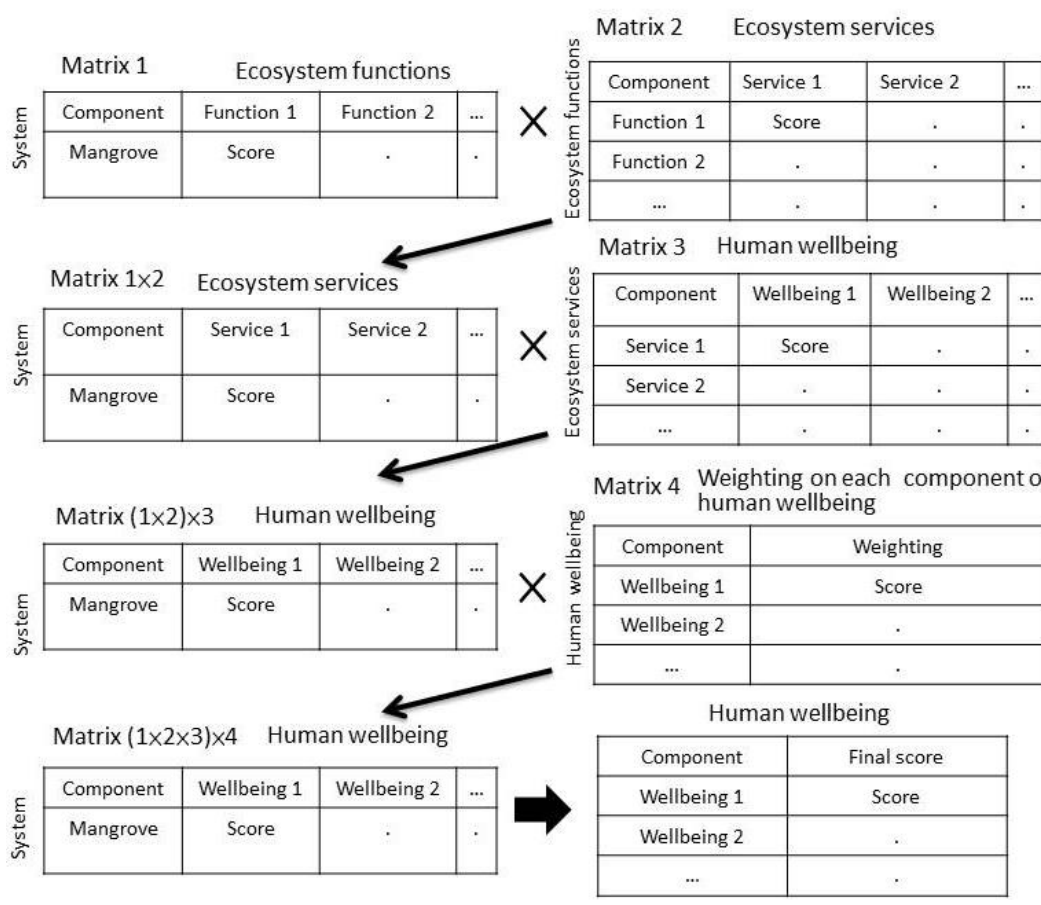
Figure 2. Matrices used by expert panel to score and prioritize components of ecosystem functions, services, and human wellbeing provided by the mangrove system in the Danshuei Estuary ecosystem. Notations x and arrows depict the procedures of multiplications between matrices and proceed to yield scores on the resultant matrices; x: multiplication sign. See Table 1 for the component contents and Materials and Methods session for procedure